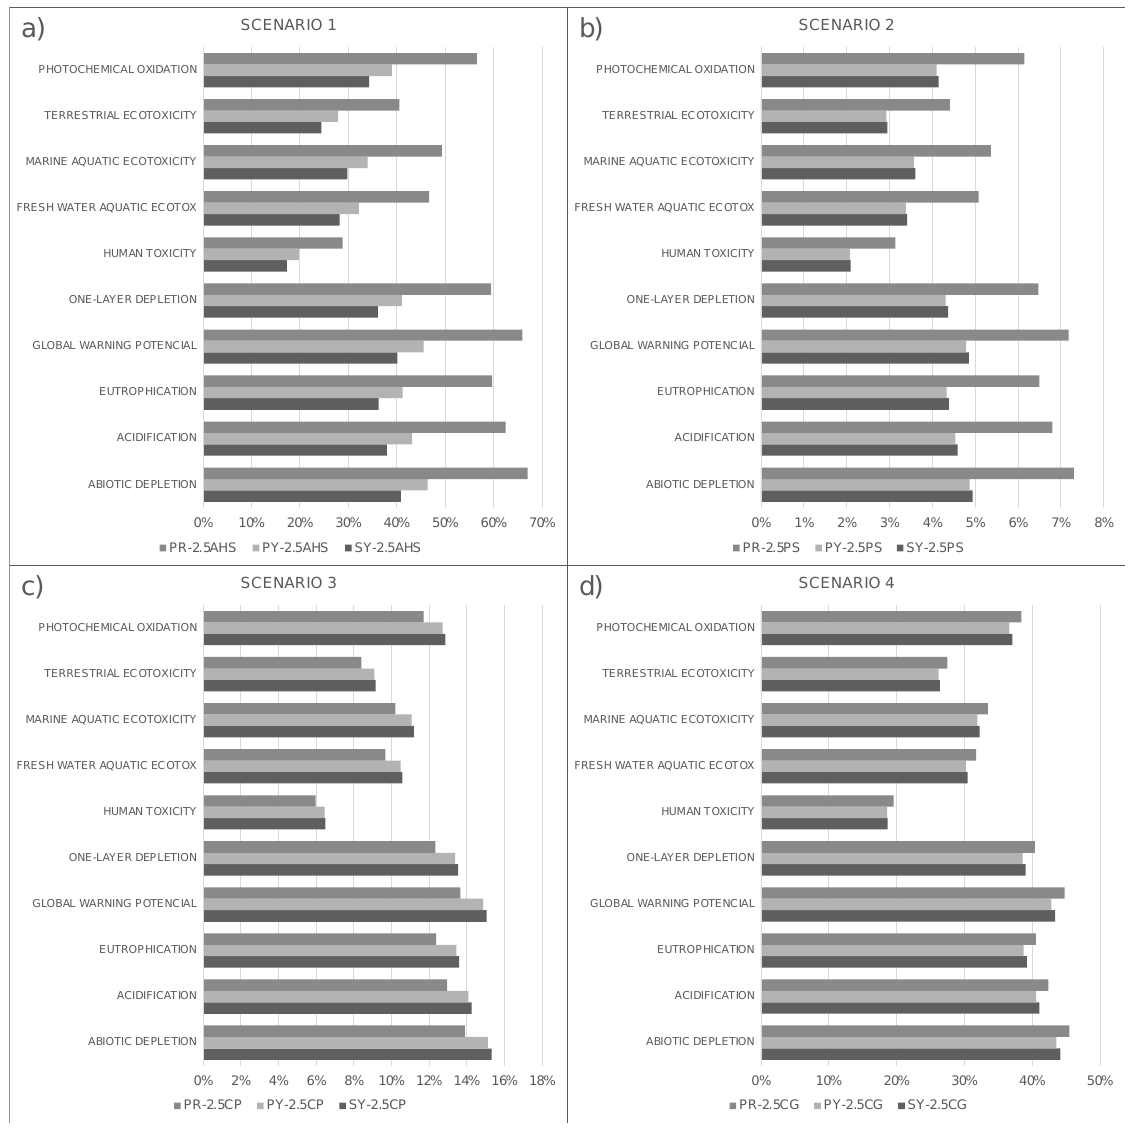
Figure 4. Comparison of the environmental benefits of the impacts characterized between light aggregates produced with 2.5 wt % waste in Scenarios 1 ( a ), 2 ( b ), 3 ( c ) and 4 ( d ) at the EXTRACTION stage.